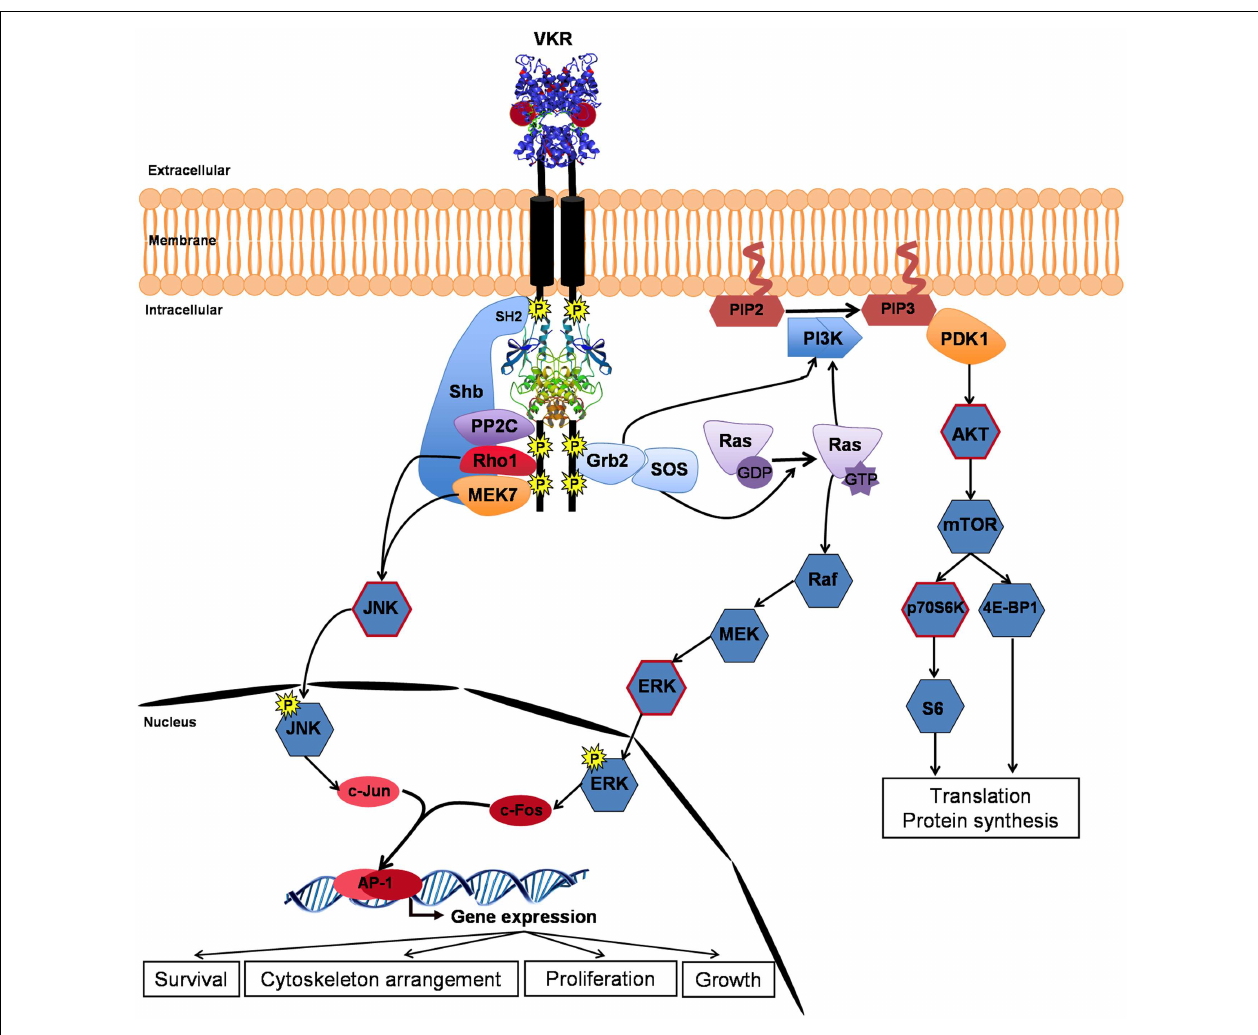
cell growth and proliferation. Moreover, activatedVKRs could activate through the specific binding of Shb (SH2-containing protein), the alternative JNK pathway to contribute in concert with Rho1, MEK7, and PP2C to cytoskeleton rearrangement and oocyte maturation. Phosphorylation of AKT, p70S6K, ERK, and JNK (circled in red) was confirmed inVKR-expressing Xenopus oocytes